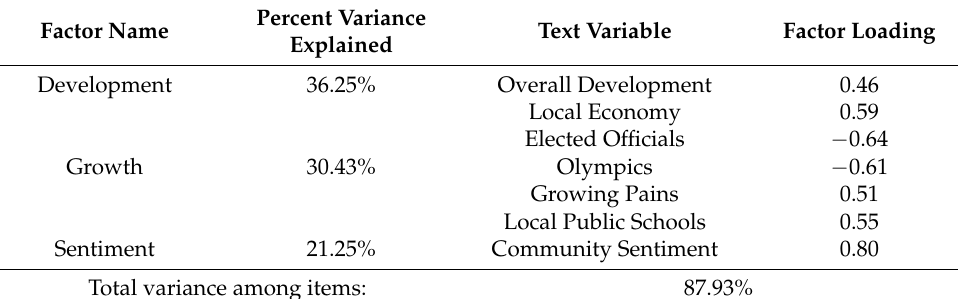
Table 5. Principal Component Analysis of Textual